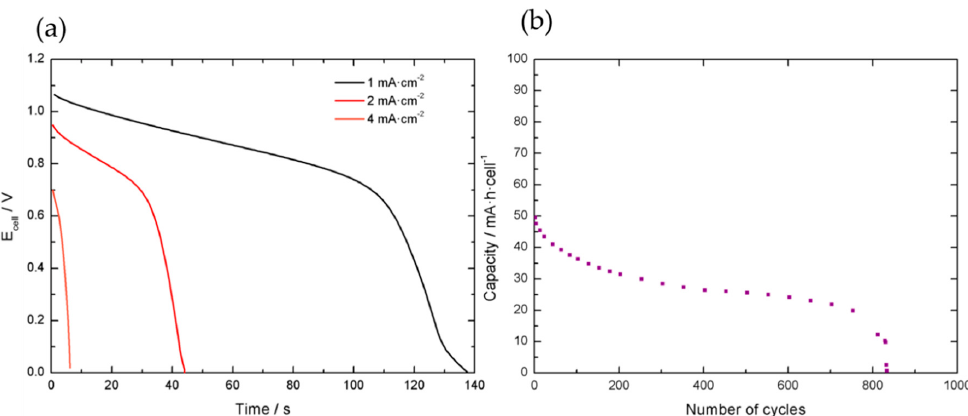
Figure 14. ( a ) Galvanostatic discharge curves for different applied current densities in the 0.0 V to 1.2 V range for a coin cell. ( b ) Cycling stability test for a coin cell in the 0.0 V to 1.2 V voltage range at 1 mA cm − 2 .